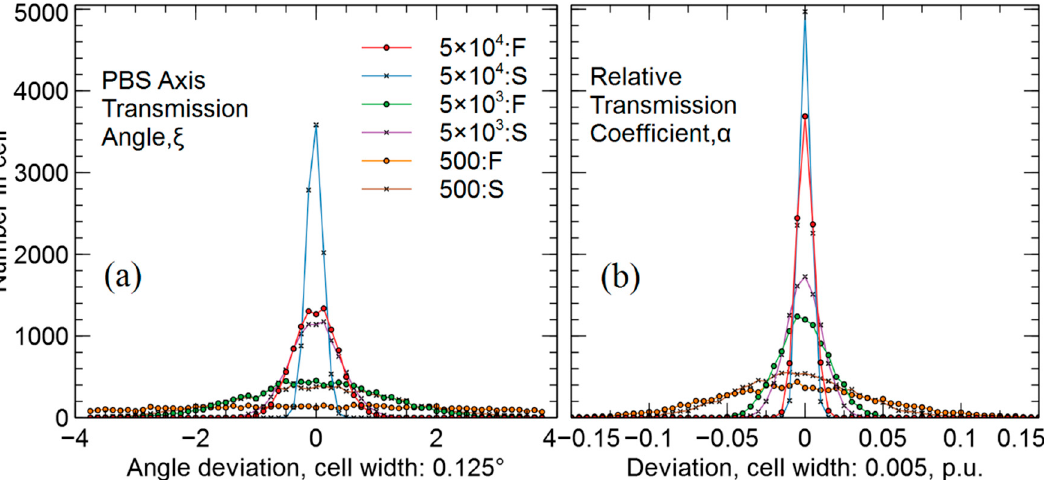
  > > ( a ) and α ( b ). The des- ξ ( a ) and α ( b ). The designations